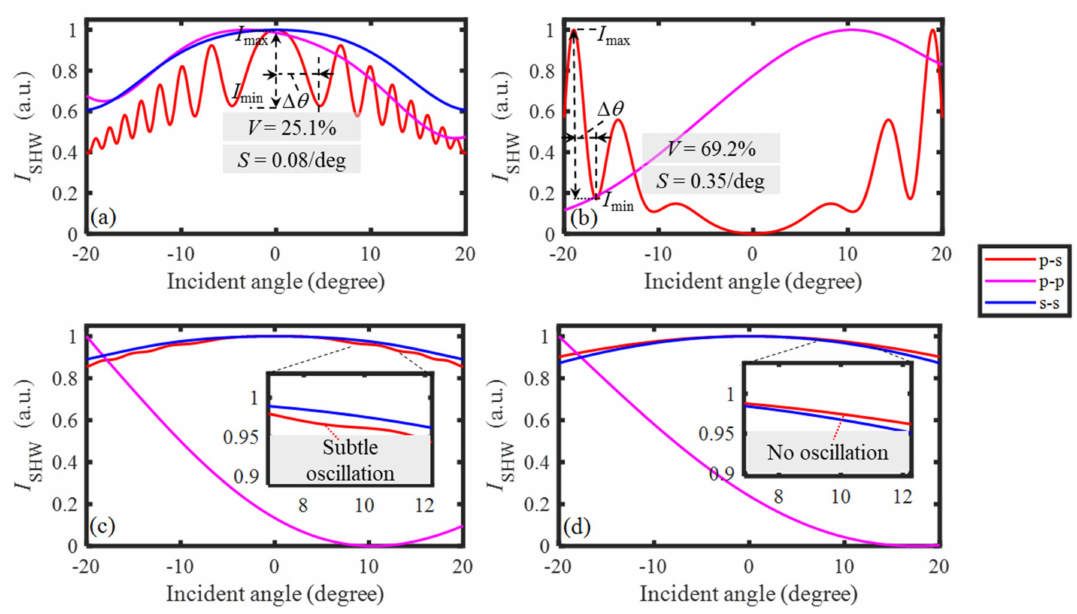
Figure 6. The angular dependence of the total intensity of the second harmonic wave. ( a ) BBO; ( b ) KDP; ( c ) LiNbO 3 ; ( d ) Ag 3 AsS 3